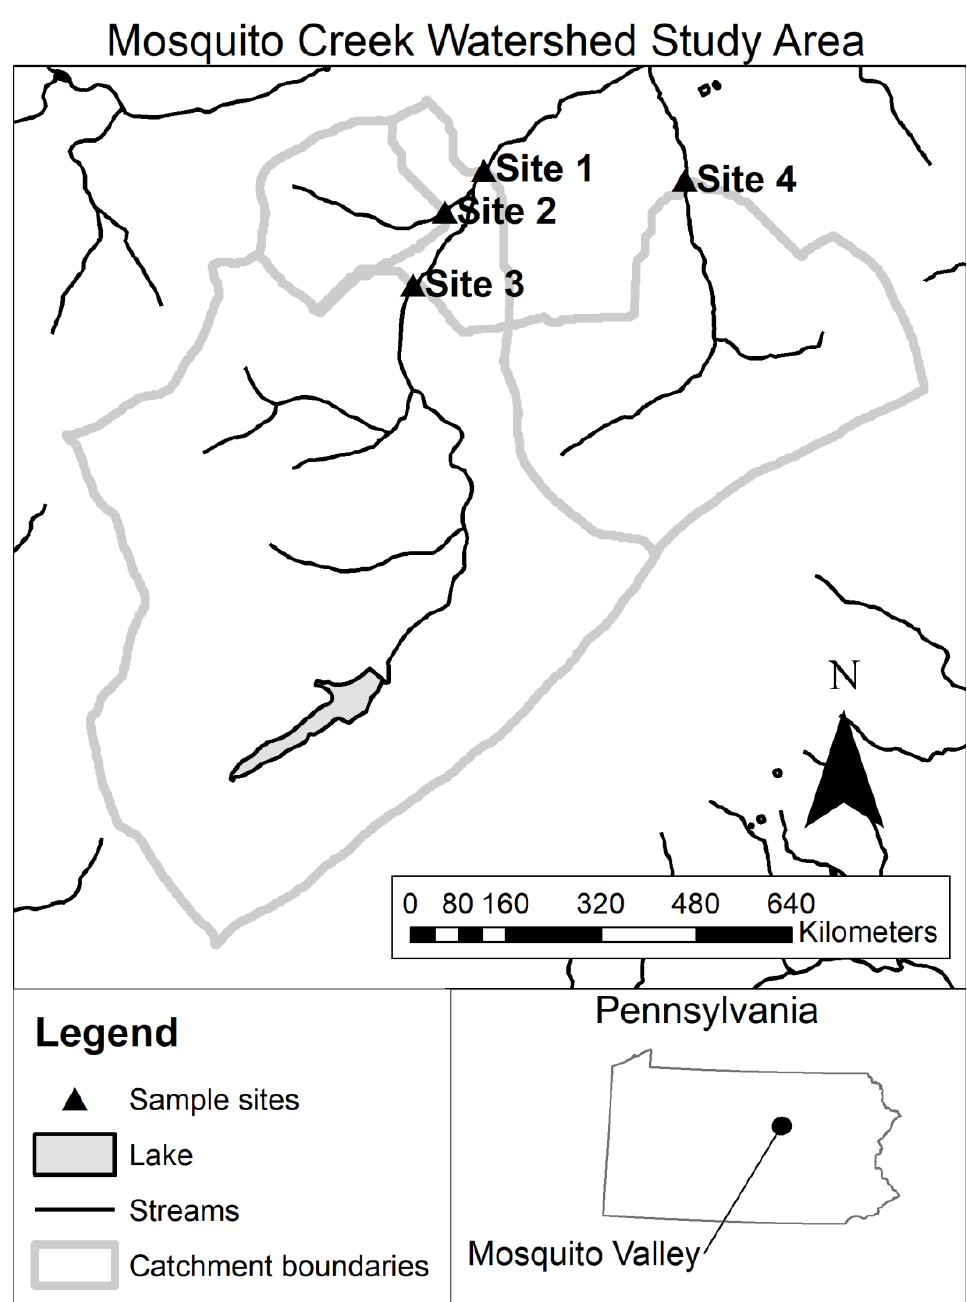
Figure 1. Map of study sites in the Mosquito Creek watershed.